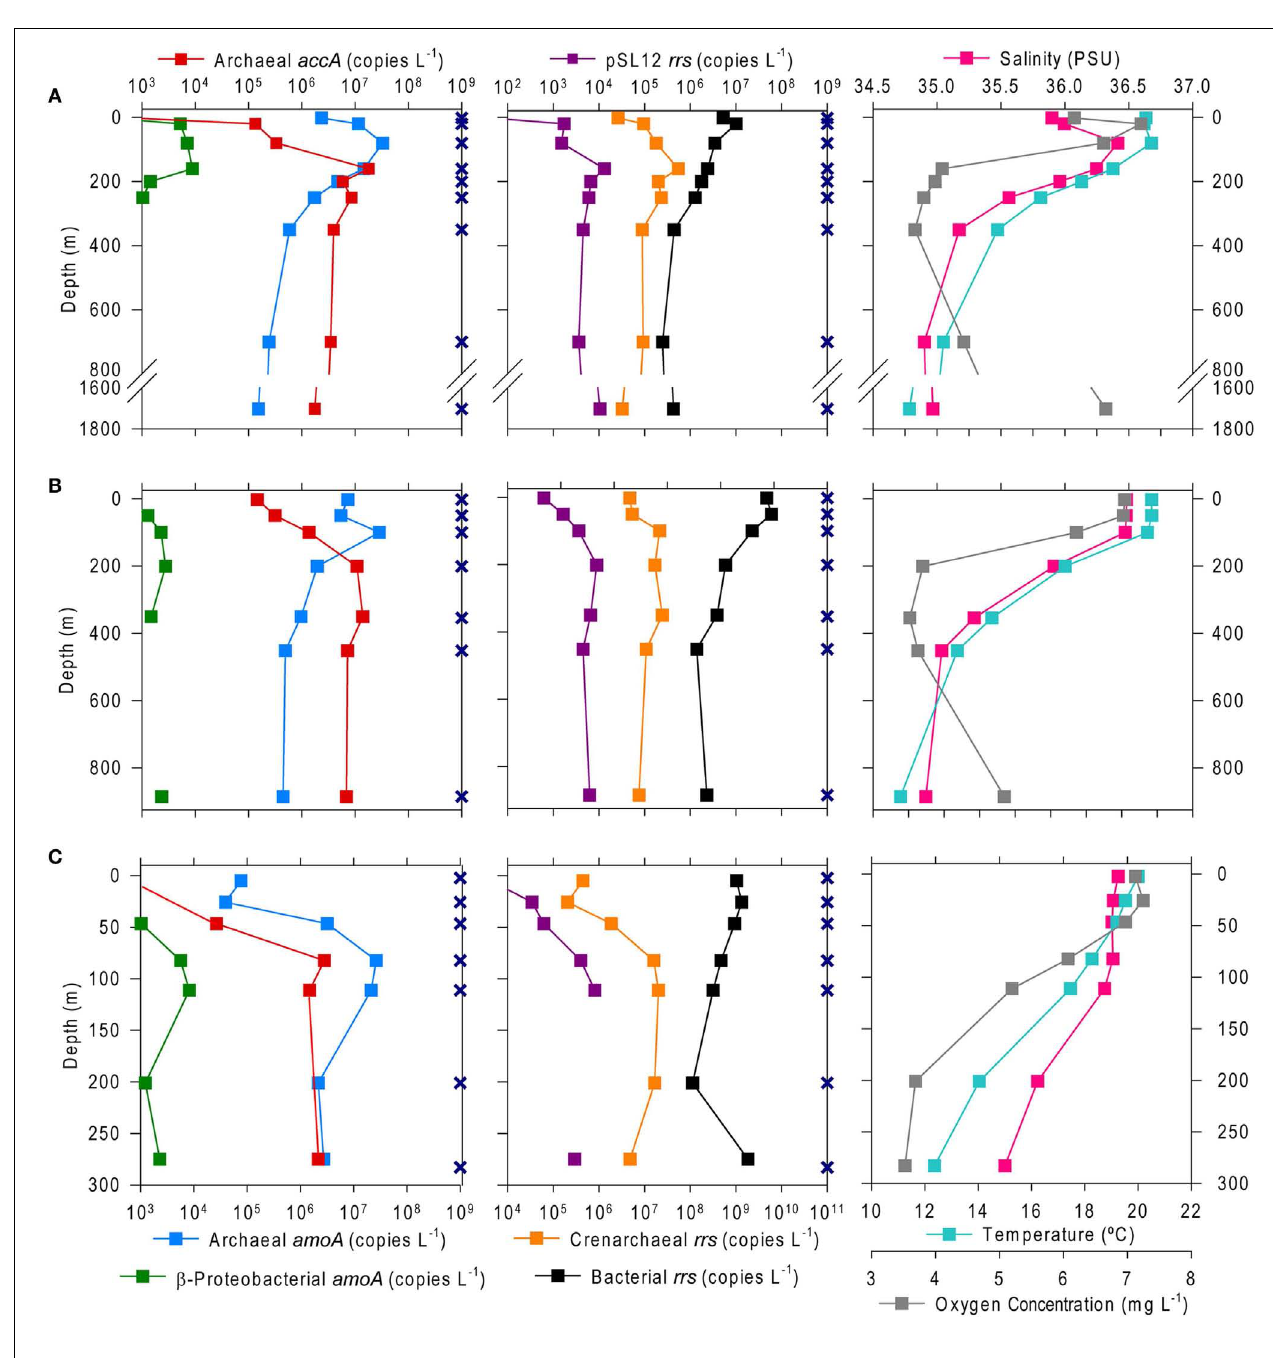
amoA and pSL12 rrs are reduced by 10–100 to allow for visualization of variation with depth. Environmental data were taken from a CTD attached to the frame of the rosette sampler (right). Sampling depths are shown as X’s on the depth axis; missing points indicate that the measurement was below the limit of detection (see TableA1 in Appendix for detection